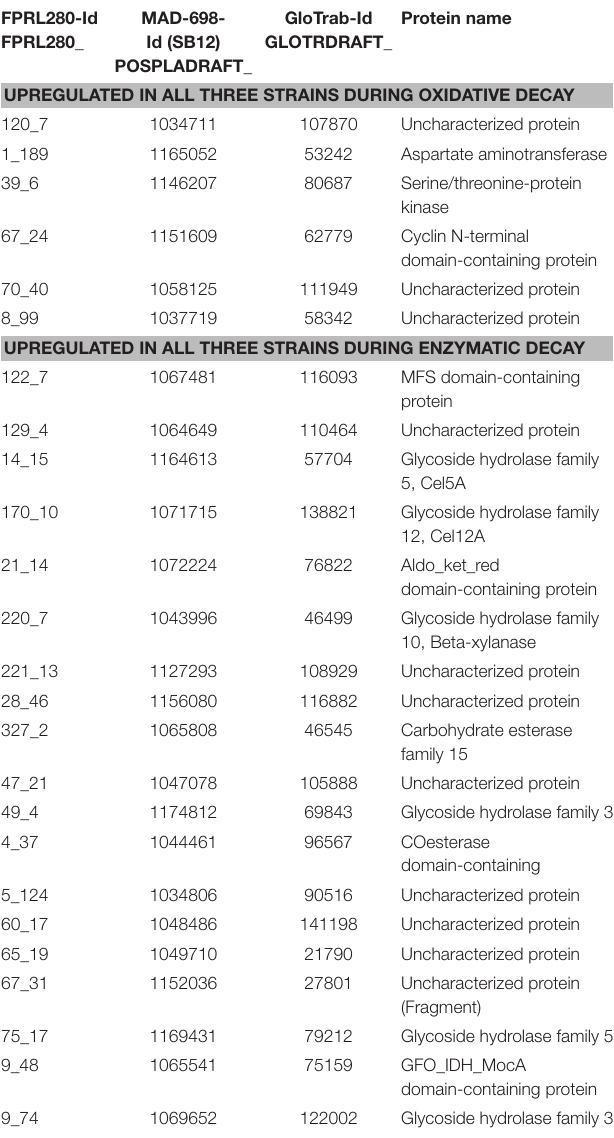
TABLE 1 | Genes that are significantly upregulated during either oxidative or enzymatic decay in all three strains R. placenta FPRL280, MAD-698 and G. trabeum with their protein